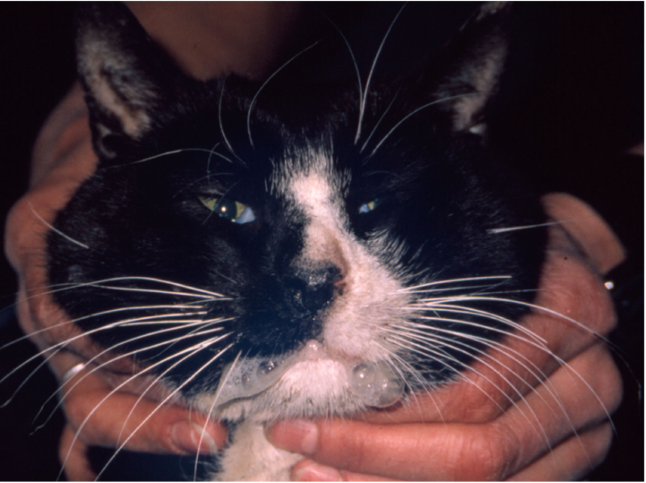
Figure 5. Hypersalivation in a cat with FCV infection. Tongue ulceration can be very painful, leading to impaired food and water uptake and hypersalivation. ©Tadeusz